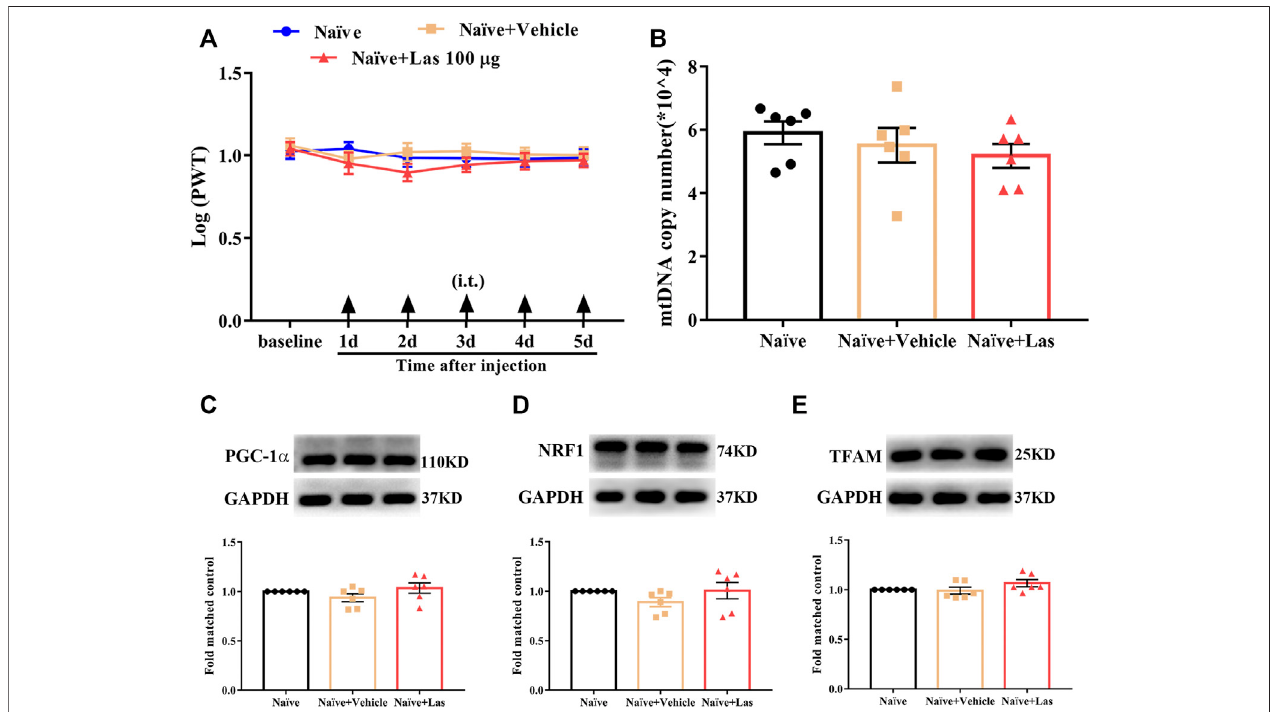
FIGURE 7 | Effect of 5-HT 1F receptor agonist on PWT and mitochondrial biogenesis in naïve rats. (A) No signi fi cant change regarding PWT was observed after lasmiditan injection at any time of the observation period ( p > 0.05 compared with Naïve + Vehicle group, n = 10 in each group). (B) No signi fi cant change regarding mtDNA copy number wasobservedafter lasmiditantreatment ( p > 0.05compared withNaïve +Vehicle group, n=6ineach group). (C) Nosigni fi cantchange regarding theproteinlevelofPGC-1 α wasobservedafterlasmiditantreatment( p > 0.05comparedwithNaïve+Vehiclegroup,n=6ineachgroup). (D) Nosigni fi cantchange regarding the protein level of NRF1 was observed after lasmiditan treatment ( p > 0.05 compared with Naïve + Vehicle group, n = 6 in each group). (E) No signi fi cant change regarding the protein level of TFAM was observed after lasmiditan treatment ( p > 0.05 compared with Naïve + Vehicle group, n = 6 in each group).